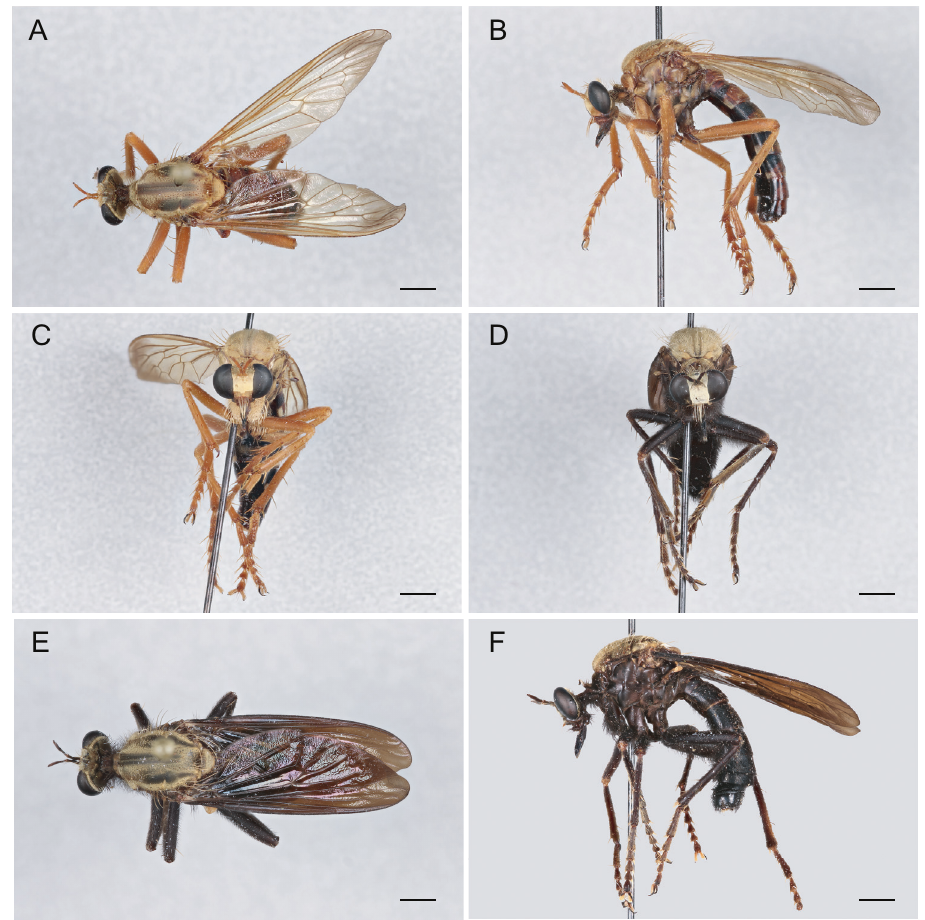
Figure 10. Saropogon combustus Loew, 1874 Female (USNMENT01819131): A dorsal view B lateral view C anterior view; Male (USNMENT01819138): D anterior view E dorsal view F lateral view. Scale bars: 2